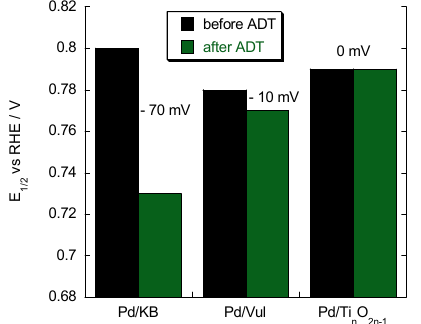
Figure 8. E 1/2 of Pd/support catalysts before and after degradation cycles. Scan rate 5 mV·s − 1 ; 1000 rpm; room temperature and 50 μ g·cm − 2 of Pd loading.